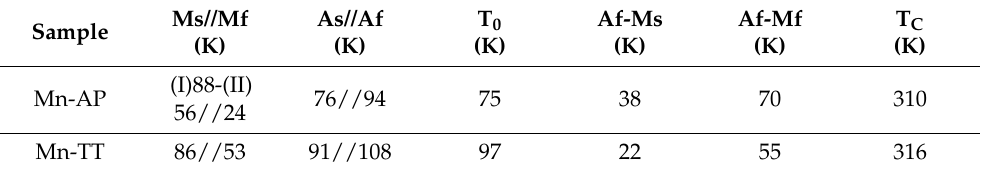
Table 2. The characteristic temperatures—martensite start (Ms) and finish (Mf), austenite start (As) and finish, (Af)—the range of martensitic transformation (Af-Mf), the thermal hysteresis Af-Ms the Curie temperatures (Tc) for as-prepared and after TT samples determined from the thermo-magnetic measurements. The thermodynamic equilibrium temperature T 0 is definite as T 0 = (Ms +